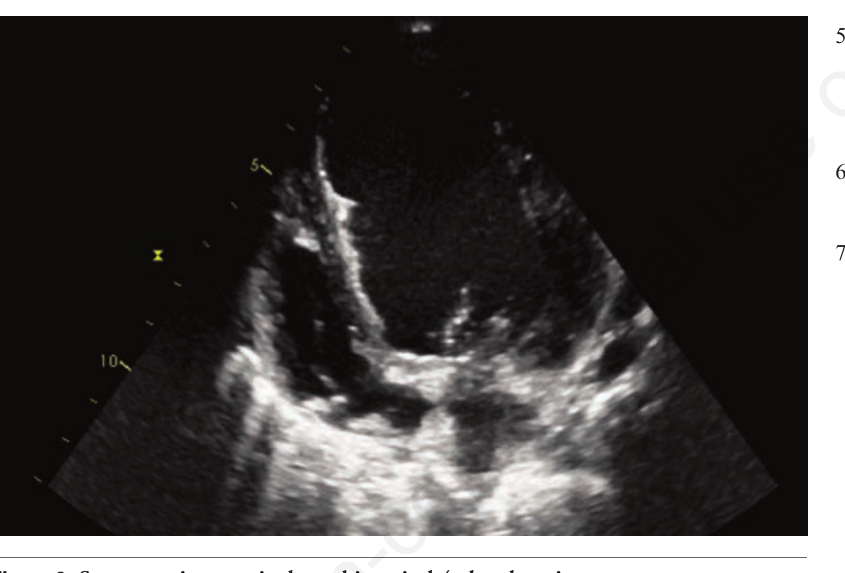
Figure 2. Severe aortic stenosis showed in apical 4-chamber